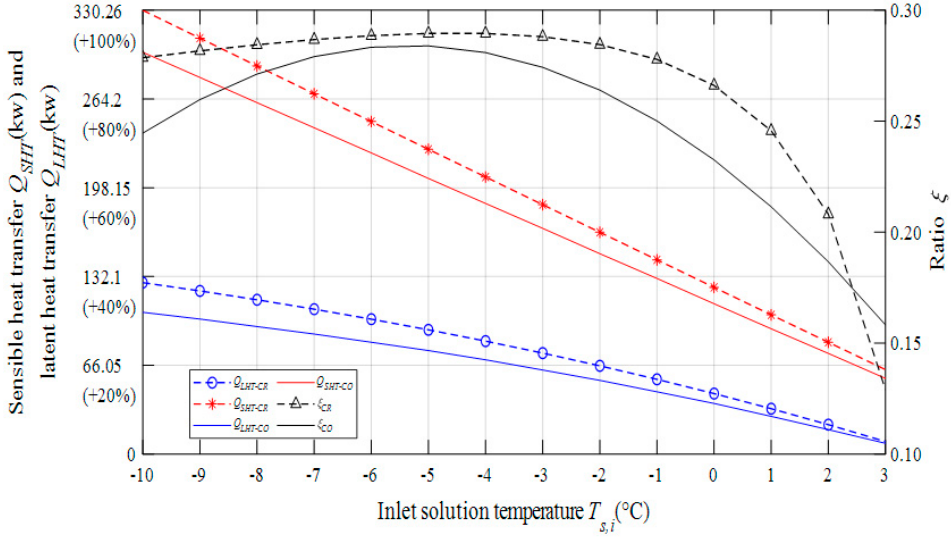
Figure 15. Influence of solution inlet temperature on energy transfer characteristics.